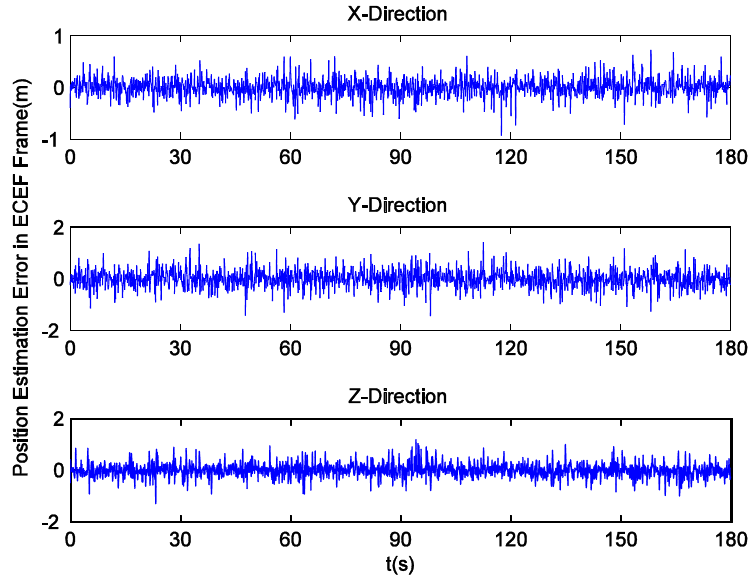
Figure 14. GPS position estimation errors with simulation data.